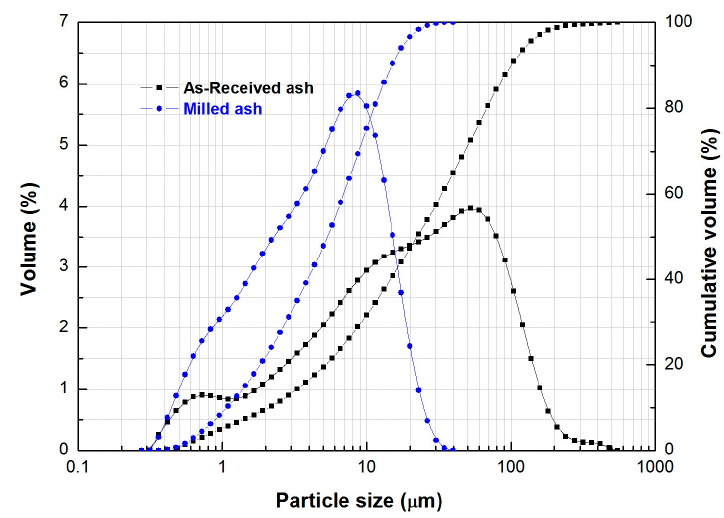
Figure 1. Particle size distribution for as-received ash and milled ash analysed by means of a laser diffractometer. Top cut (D97) particle size was reduced from 156.2 to 20.5 μ m. Table 2. Chemical composition of the fly ash used in this study (wt %). LOI = loss on ignition. SiO 2 Al 2 O